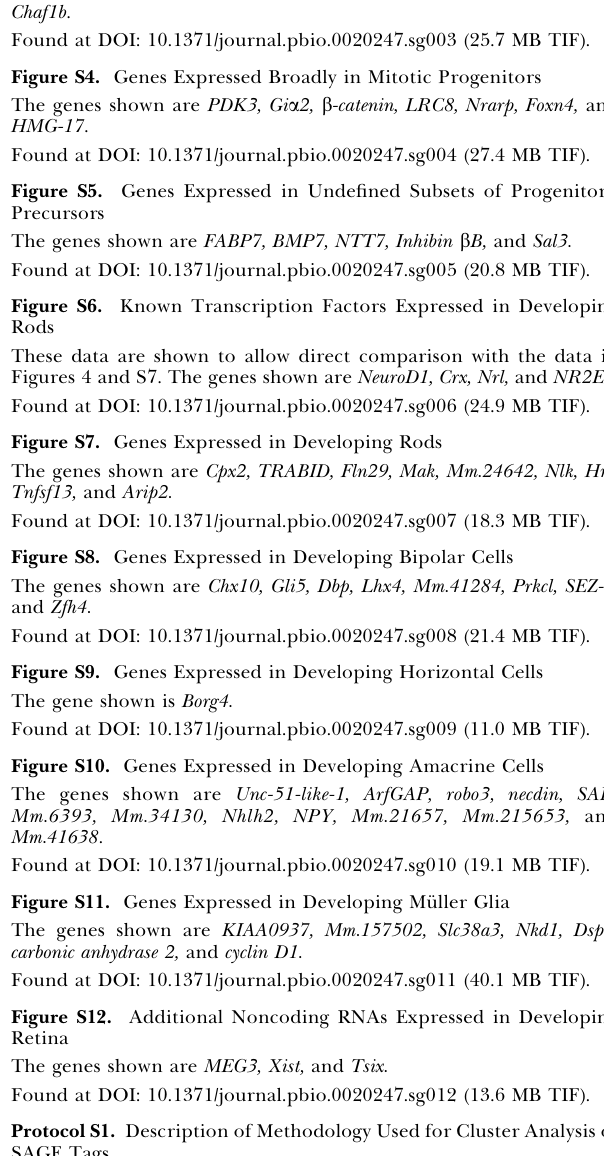
Figure S1. Comparison of E14.5 EST Versus E14.5 SAGE Data